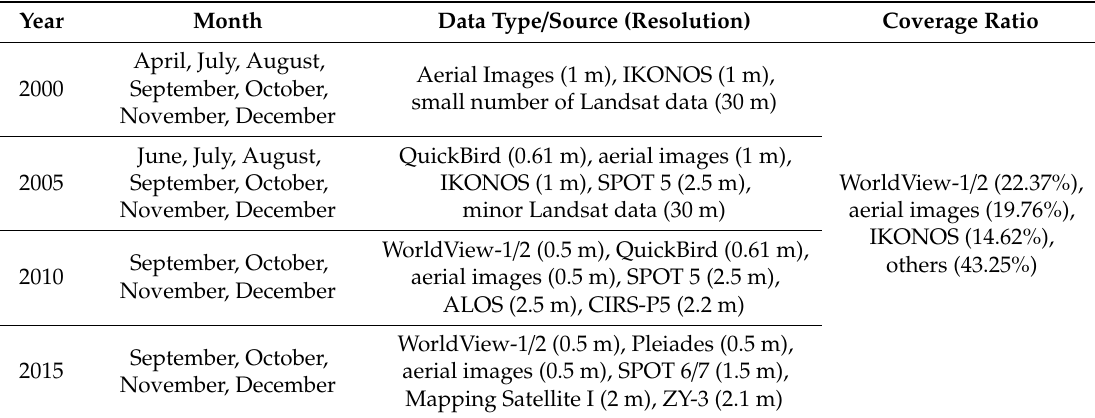
Table 1. Primary remote sensing image data used in this study.